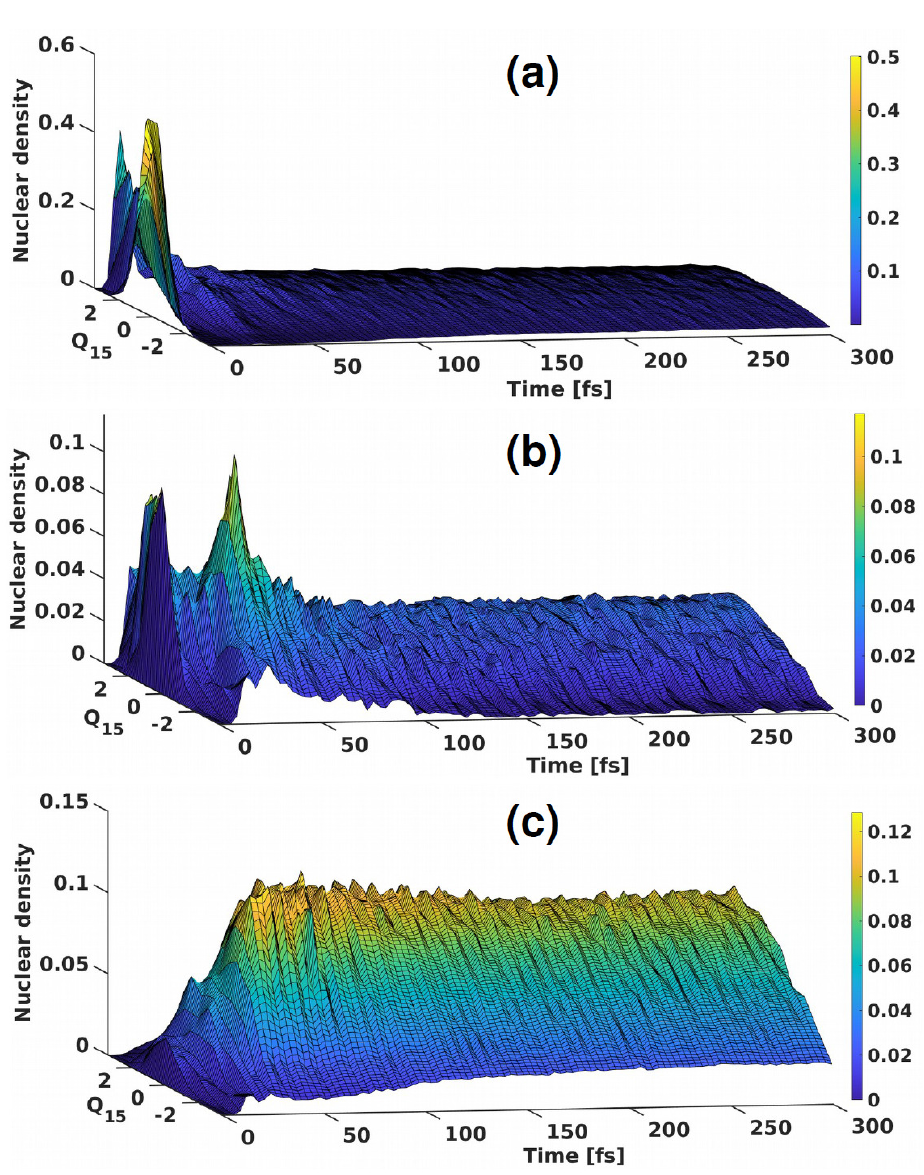
Figure 6. Nuclear densities variation of ( a ) S 3 , ( b ) S 2 , and ( c ) S 1 along Q 15 of C 7 H 4 , obtained by propagating initial wavepacket on the “bright” S 3